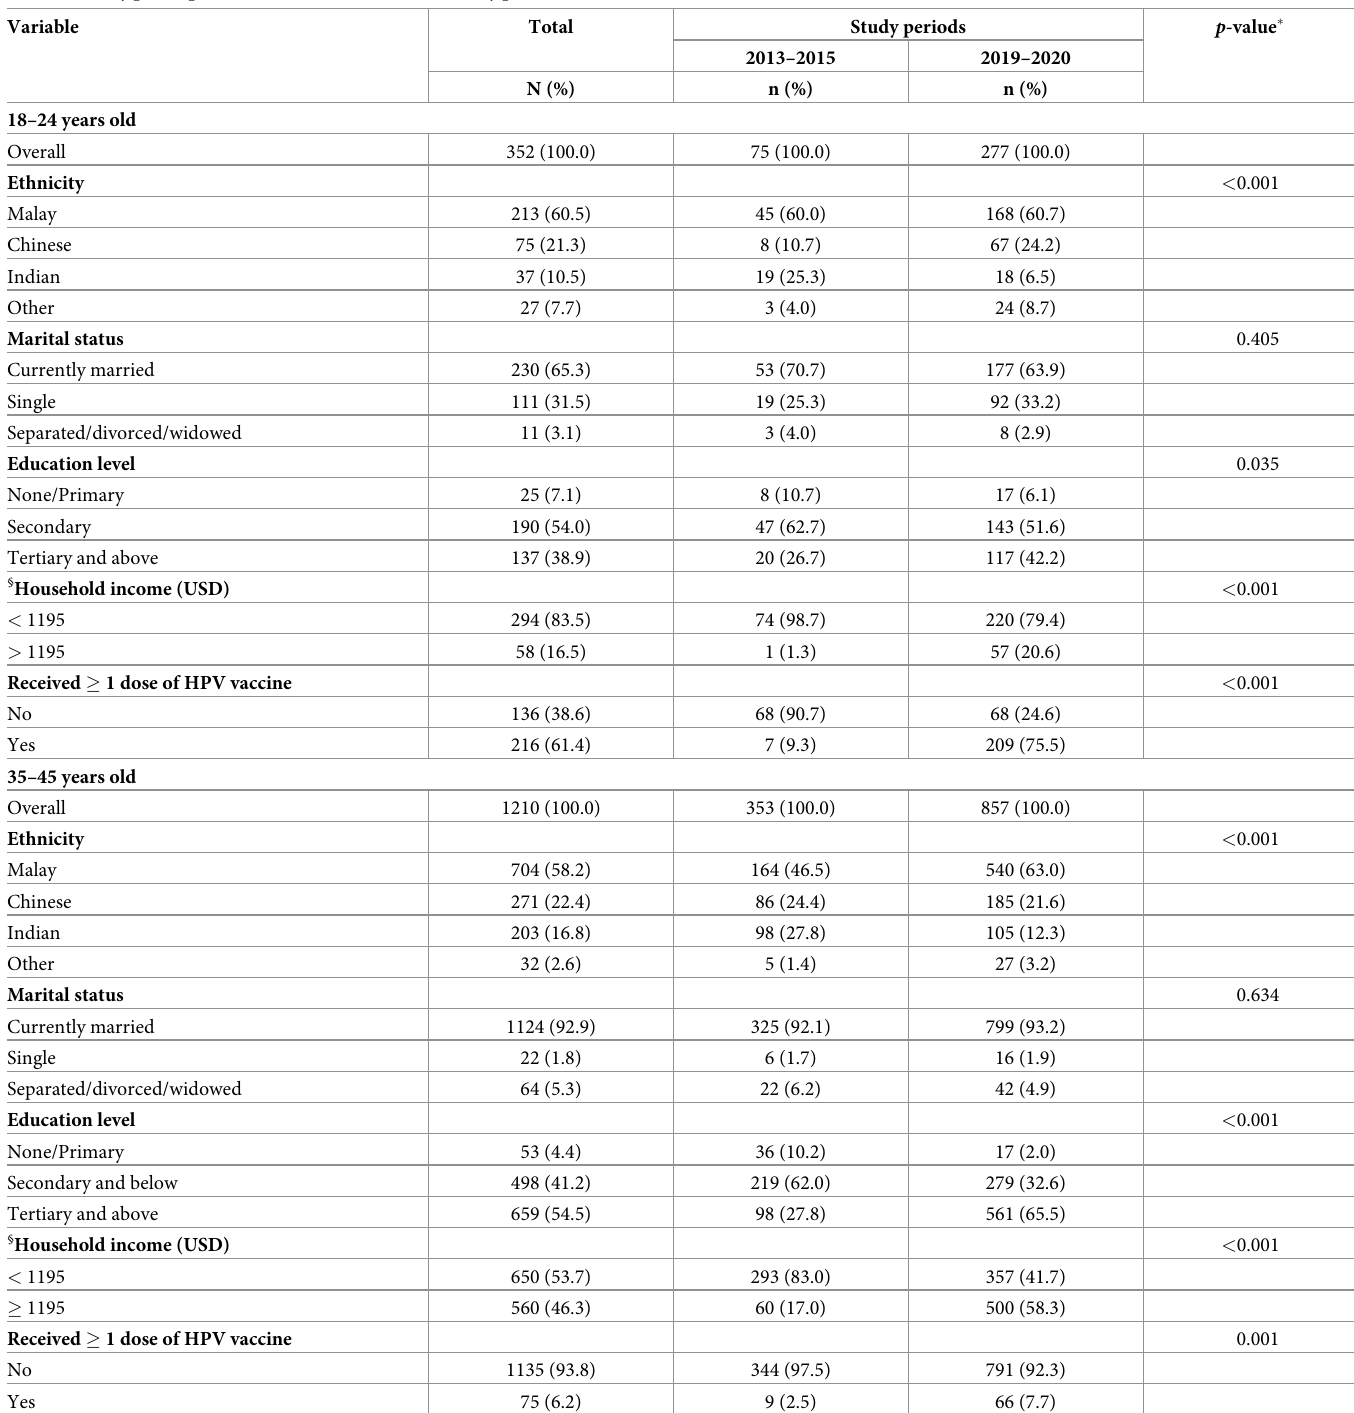
Table 1. Study participants characteristics across two study